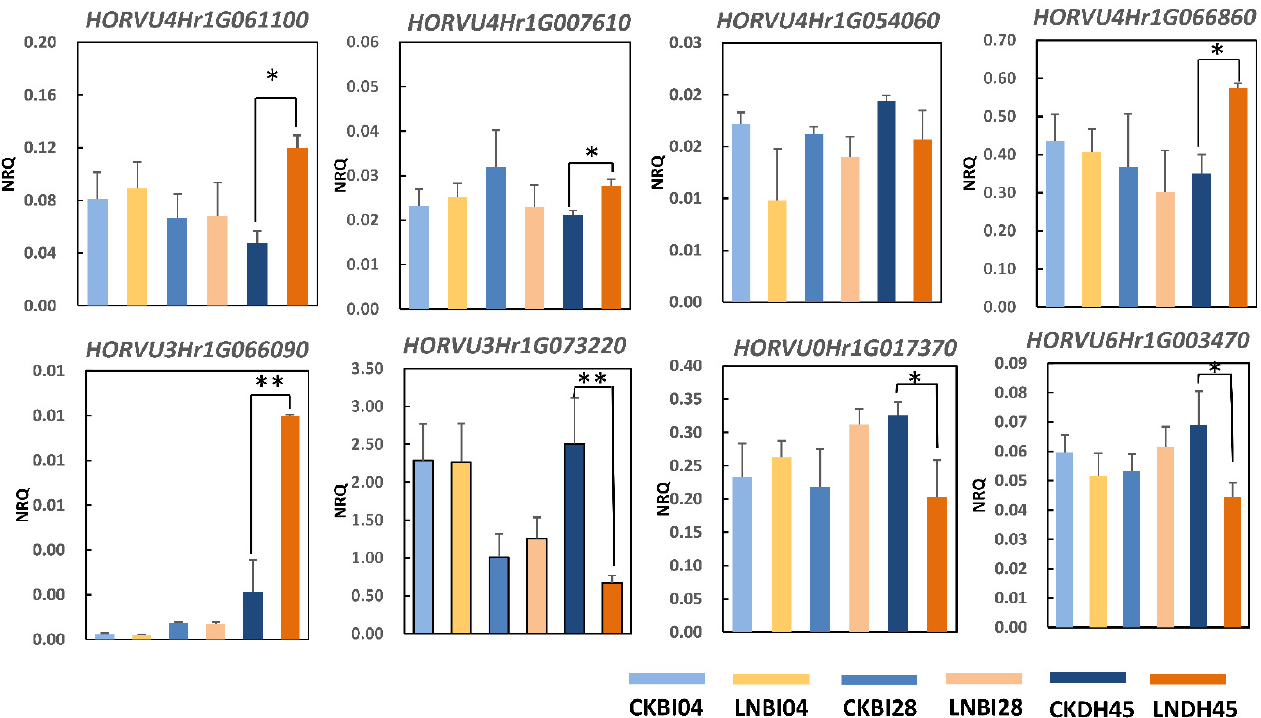
Figure 7. Validation of eight DEG HP by quantitative real-time PCR. The X axes represent the barley samples from the parents (BI04 and BI28) and their offspring (DH45) under CK conditions and low nitrogen treatment, and the y axes represent the normalized relative quantity of gene expression. The normalized relative quantity (NRQ) is calculated as a target gene’s expression with respect to two endogenous reference genes: HvGAPDH and HvActin . * indicate significant differences at 0.05 levels by Student’s t test. All data represent three biological replicates. ** indicate significant differences at 0.01 levels by Student’s t test.